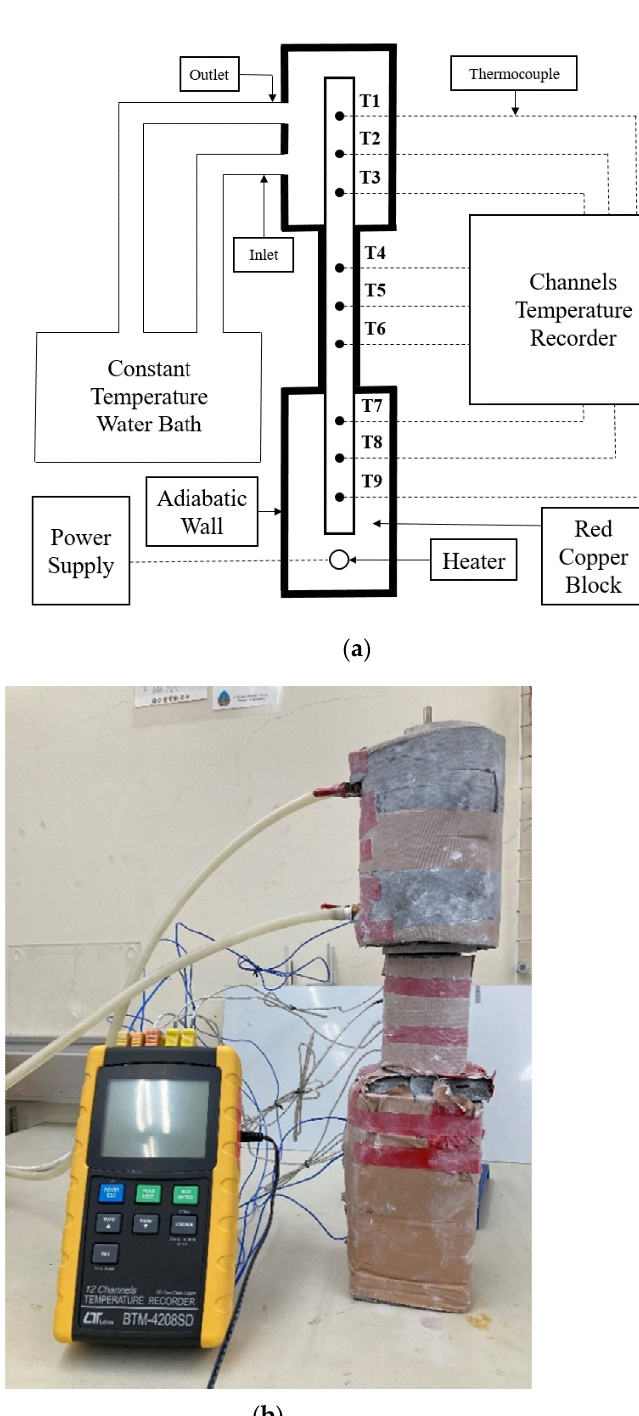
Figure 2. Experimental system: ( a ) schematic diagram, ( b ) photographic appearance.